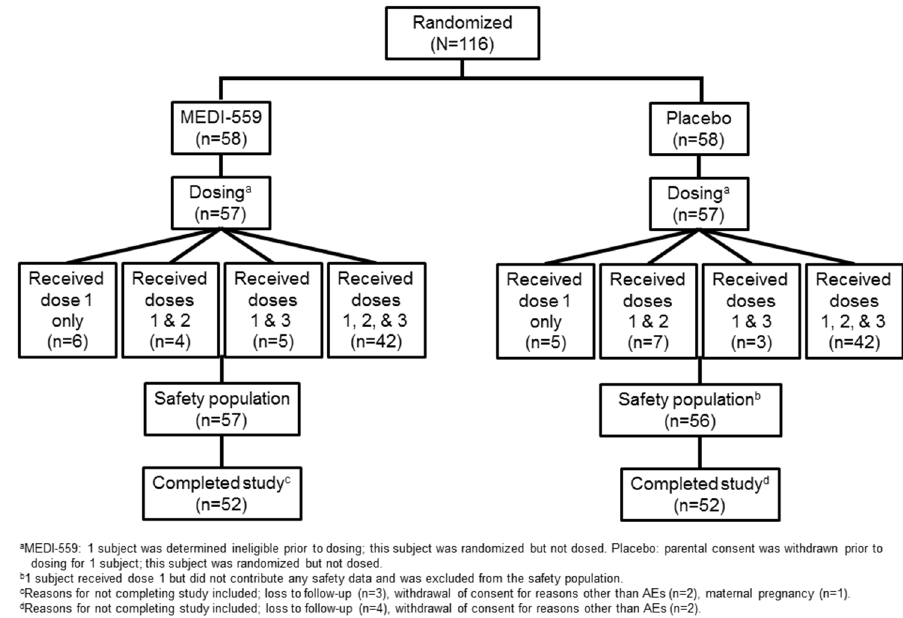
Figure 1. Subject disposition (CONSORT